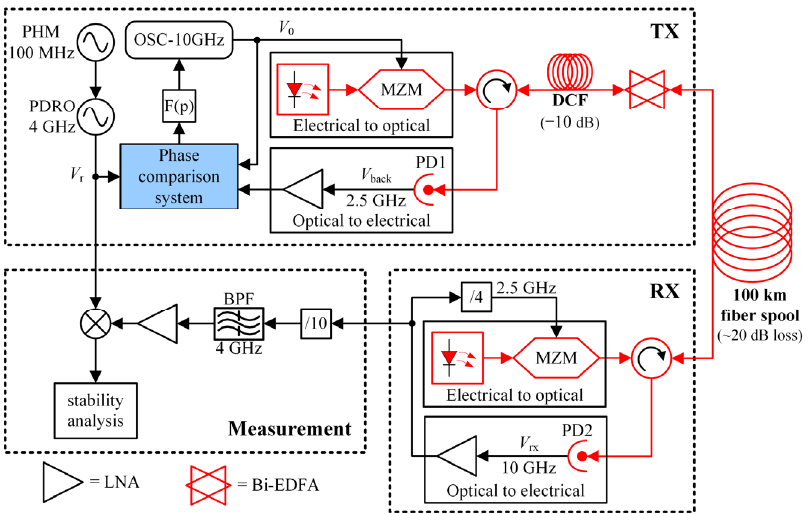
Figure 2. Schematic of the 10-GHz transfer system over a 100-km fiber spool. PDRO: phase-locked dielectric resonant oscillator; MZM: Mach–Zehnder modulator; DCF: dispersion-compensating fiber; Bi-EDFA: bidirectional erbium-doped fiber amplifier; LNA: low noise amplifier; OSC-10GHz: containing a 100-MHz OCXO and a 10-GHz PDRO; BPF: band pass filter.